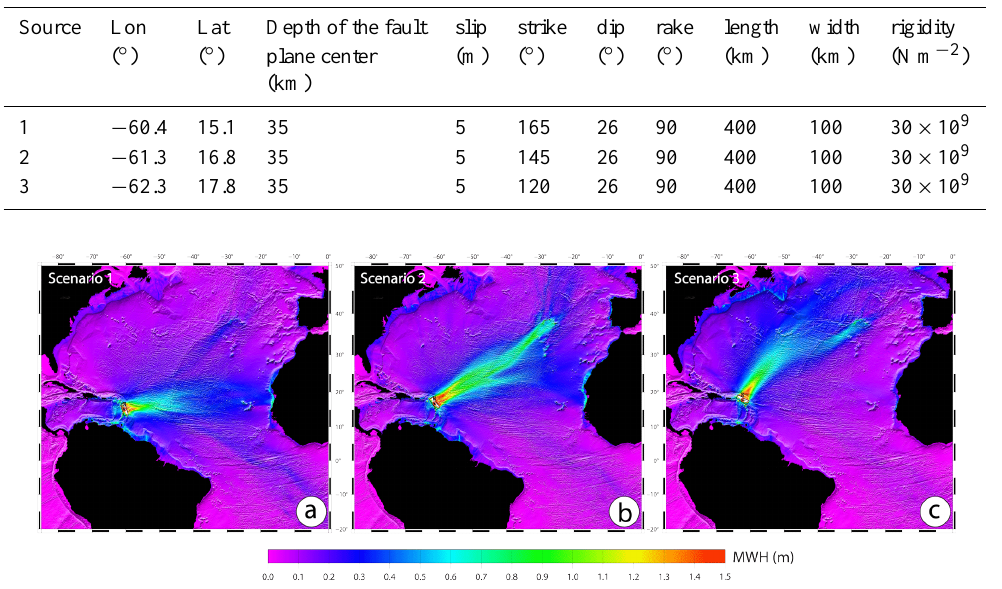
Figure 3. Maximum wave height maps over the Atlantic Ocean, after 12h of tsunami propagation, for 3 different locations and strikes of a rupture scenario of magnitude M w ∼ 8 . 4. (a) , (b) , and (c) correspond respectively to scenarios 1, 2, and 3 in Table 1.